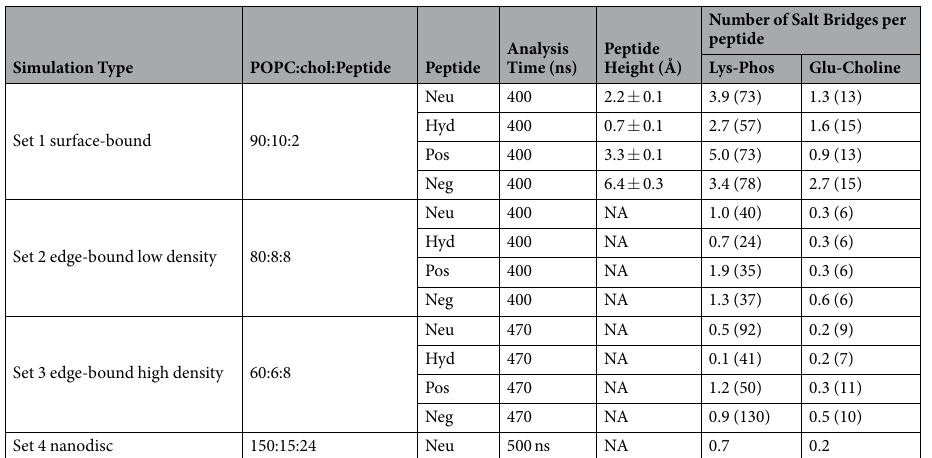
Table 2. Simulation details and results. Peptide height is defined as the vertical distance between peptides and C2 atoms of oleoyl acyl chains, and is not applicable (NA) to edge-bound simulations. Salt bridges were measured as the number of contacts between nitrogen of amino group of Lys and phosphorus of phosphate group of POPC, and carbon of carboxyl group of Glu and nitrogen of choline group of POPC, averaged over all simulation frames and divided by the number of peptides. Average lifetimes (in ps) are presented in parentheses. Lifetimes for Set 4 are not presented because the trajectory was saved every 240 ps, which is more than typical